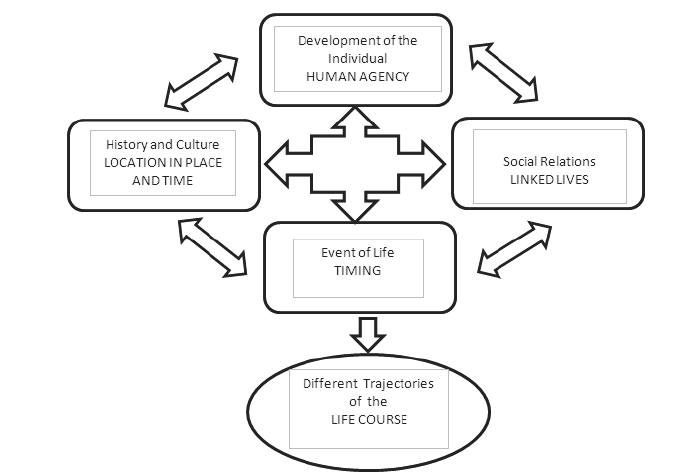
Figure 3 – Key elements of the Life Course Paradigm (Source: Giele and Elder, 1998, p.